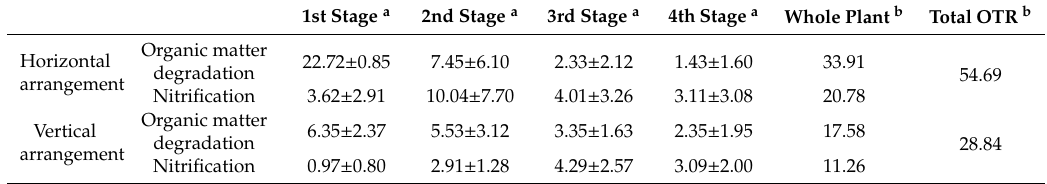
Table 2. Oxygen transfer rate expressed in g m − 2 h − 1 for the four stages of treatment of both pilot plants.